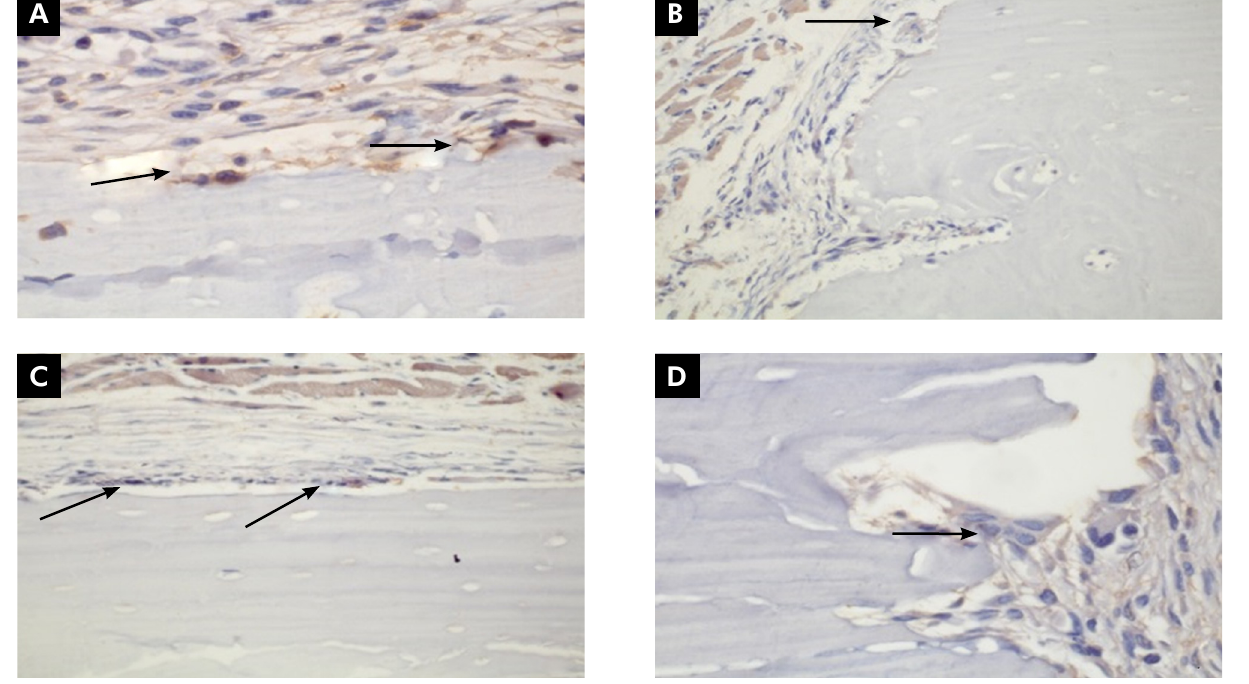
Figure 1. Photomicrographs showing the Rank staining a) Day 7 Group OVX-E: moderate labeling of osteoclast ( → ) x400. b) Day 7 Group OVX-ME: mild labeling of osteoclasts ( → ) around bone graft. x400. c) Day 21 Group SHAM-E: mild labeling of osteoclasts ( → ) x200. d) Day 21 Group SHAM-ME: mild labeling of osteoclasts ( → ) around bone graft